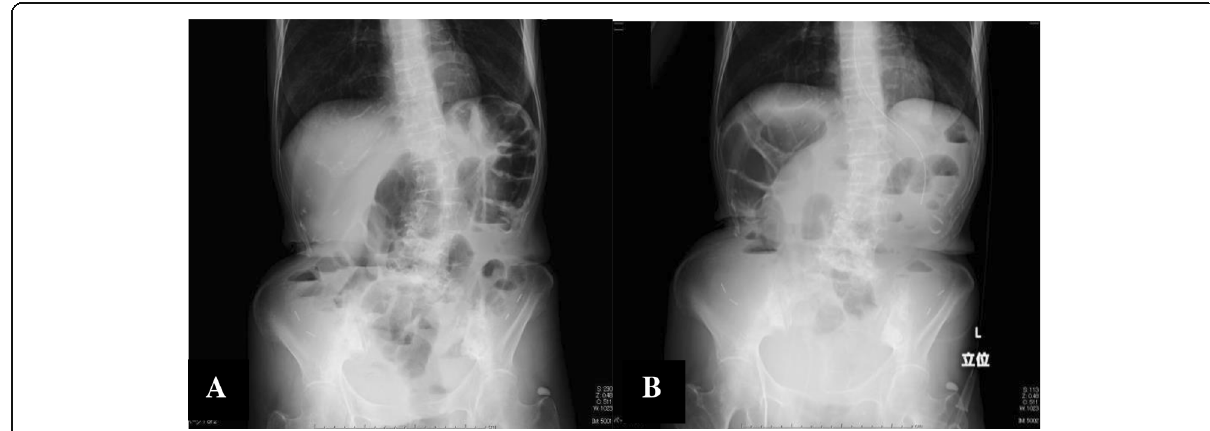
Fig. 1 a Patient ’ s abdominal X-ray at hospitalization. It shows several small intestinal niveau and extension of the colon and small intestine by intestinal gas. b Patient ’ s abdominal X-ray after the inferior mesenteric artery plexus block. The number of intestinal niveau and the amount of gas has decreased, as compared to before the